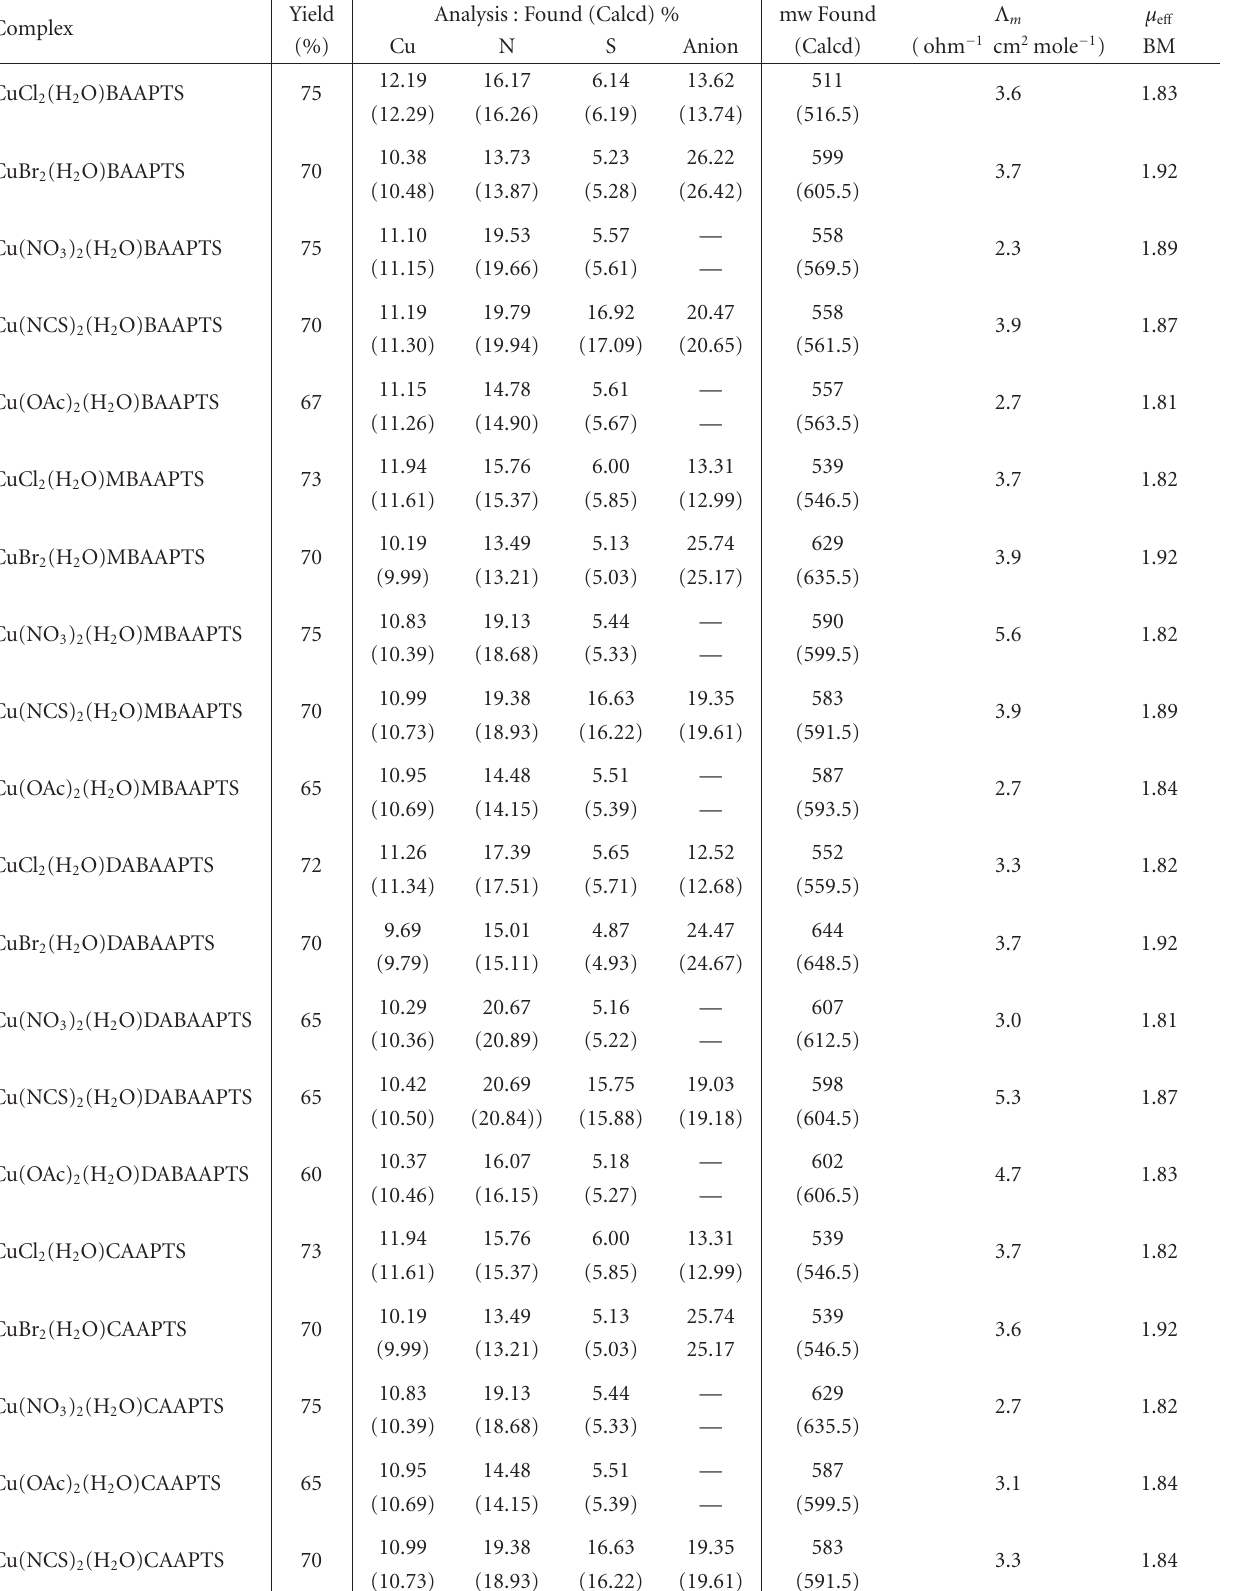
Table 1: Analytical, conductivity, molecular weight, and magnetic moment data of Cu 2+ complexes of thiosemicarbazones.